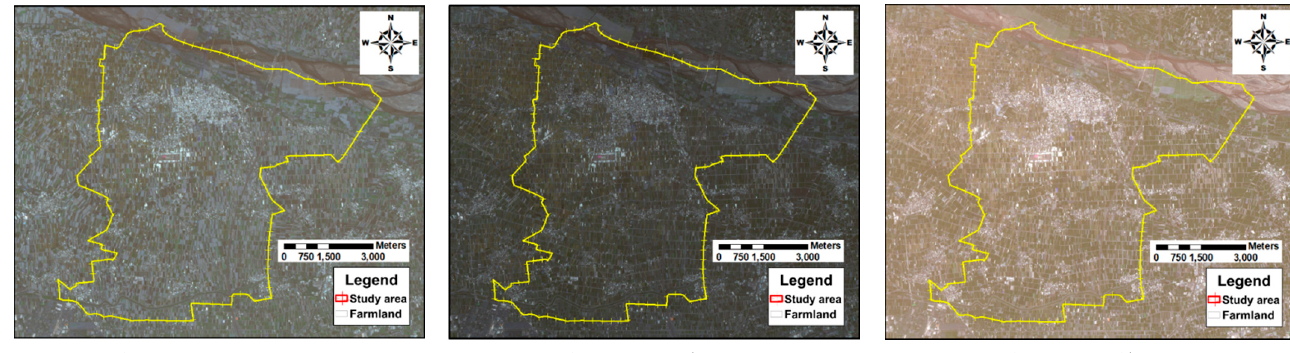
Figure 3. The selected SPOT6 satellite image. Sentinel-1A Images